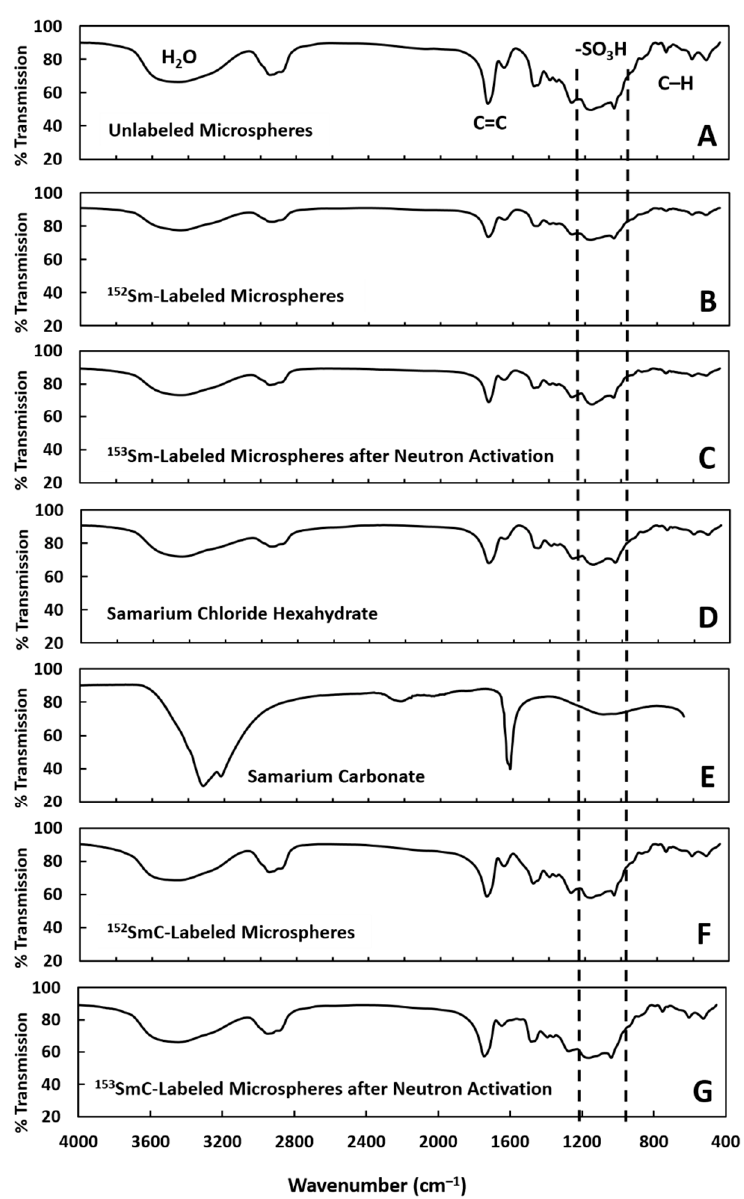
Figure 6. Fourier transform infrared (FTIR) spectra of the unlabeled microspheres ( A ), Sm-labeled microspheres ( B ) before and ( C ) after 6 h neutron activation, samarium chloride hexahydrate ( D ), samarium carbonate ( E ), and SmC-labeled microspheres ( F ) before and ( G ) after 6 h neutron activation.